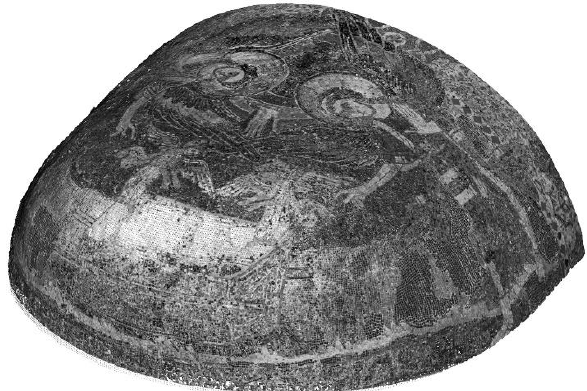
Figure 3 TLS point cloud, unrealistic view from above After unwrapping the point cloud based on NURBS calculations as in (Leal et al., 2010) and using a sub-sampled knowledge- based HPC as reference, the point cloud mosaic covering 9.38 m²